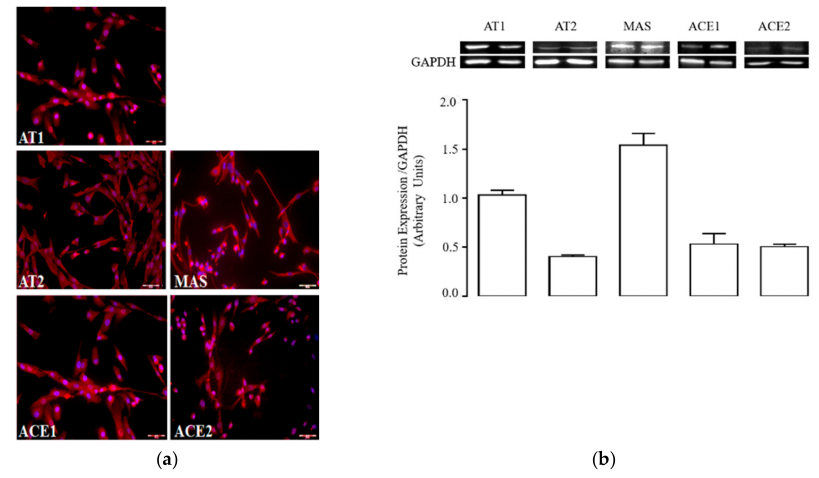
Figure 2. Expression of renin angiotensin system (RAS) proteins in activated hSCs: ( a ) immunolabelling of type-1 (AT1), type-2 (AT2), and MAS receptors, and angiotensin-converting enzymes 1 (ACE1) and 2 (ACE2) in cultured hSCs at passage 3. Target proteins are depicted in red, cell nuclei are in blue (DAPI). The image magnification is 20 × ; ( b ) immunoblotting (top) and densitometric analysis (bottom) of AT1, AT2, and MAS receptors, and ACE1 and ACE2 in protein extracts of hSCs at passage 3. The histogram shows the ratios (mean ± standard error of the mean (SEM), n = 3) between the expression levels of target proteins and